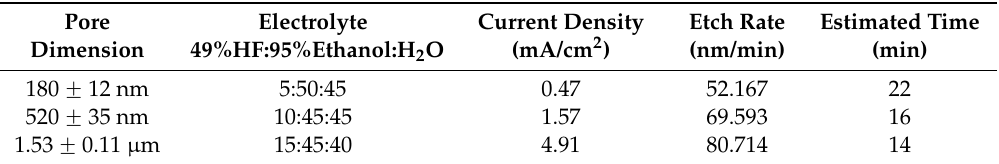
pore in a Si membrane. Thickness of each pore is about 1.17 ± 0.05 μ m.